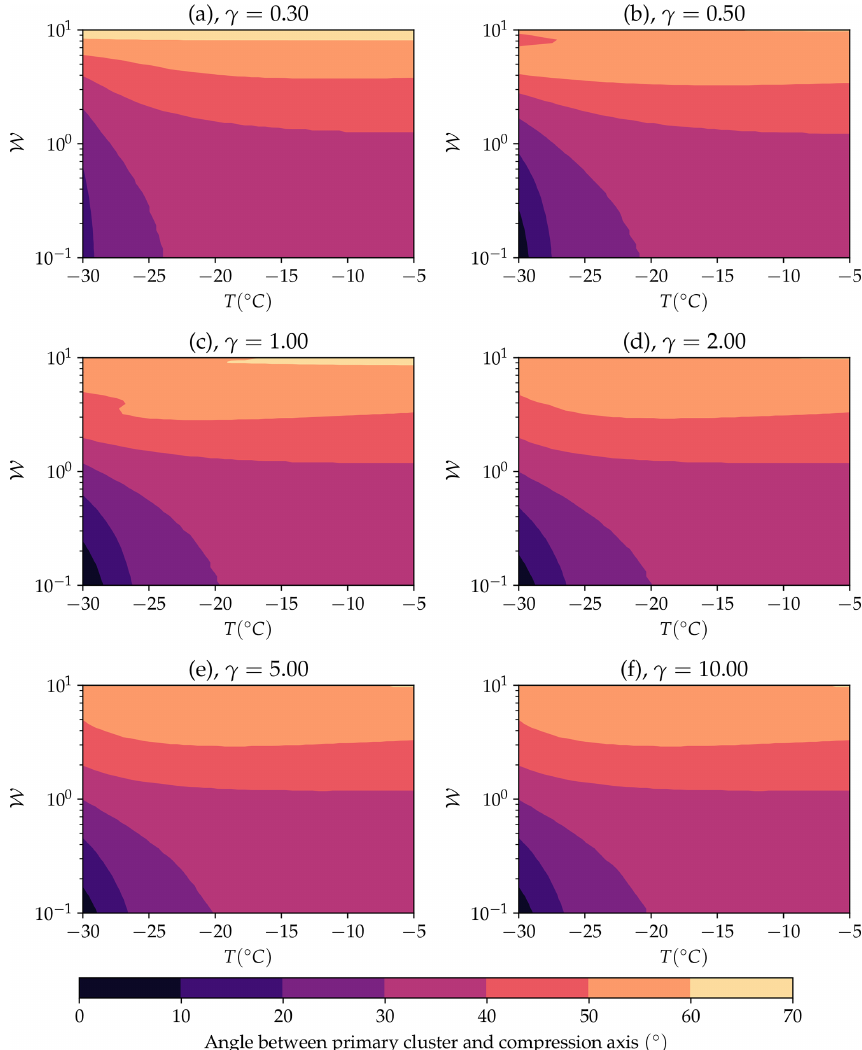
Figure 11. Contour plots showing the angle (in degrees) of the largest cluster from the compression axis. Panels are shown for progressively increasing finite strain values. The resolution of this figure is 50 × 50 across the parameter space.